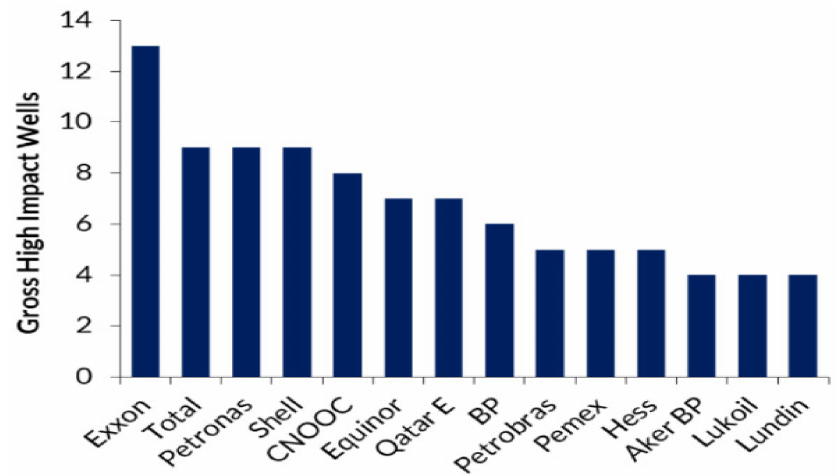
Figure 3. High impact exploration drilling activities in 2021 by different oil companies (Courtesy: Westwood Global Energy